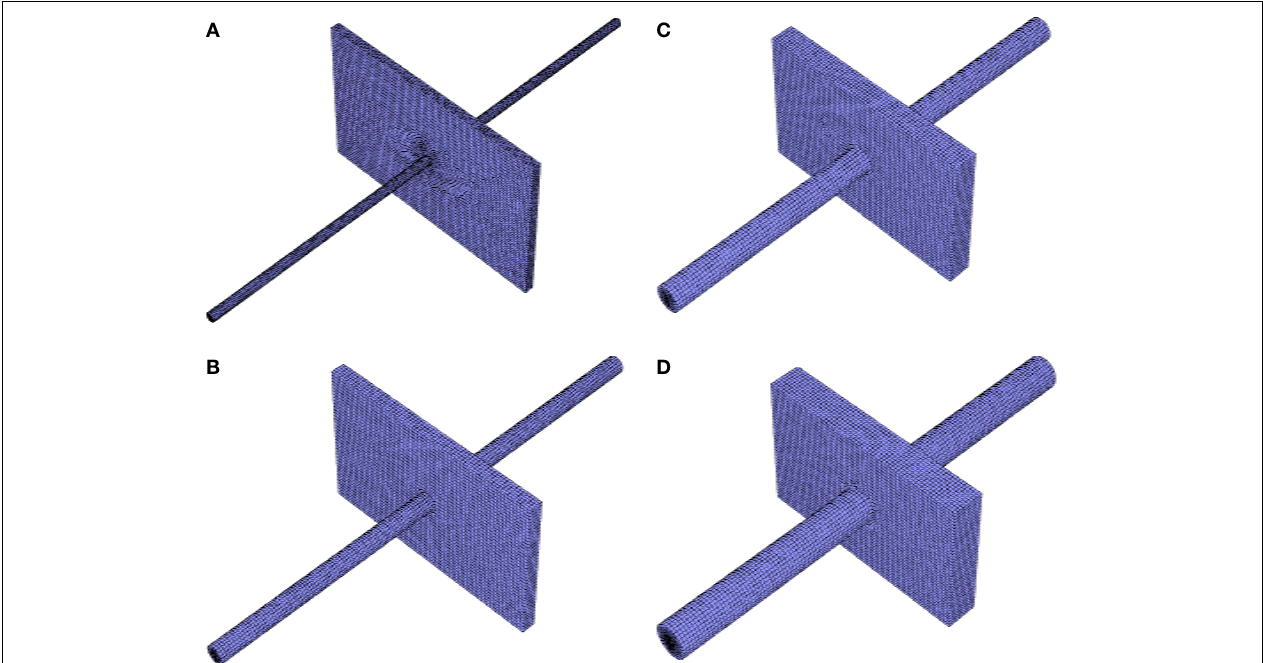
FIGURE 1 | Example meshes used for simulation: (A) 5Ah cell with 5mm diameter nail, (B) 10Ah cell with 10mm diameter nail, (C) 20Ah cell with 15mm diameter nail, (D) 30Ah cell with 20mm diameter nail, all small single sheet foil area .